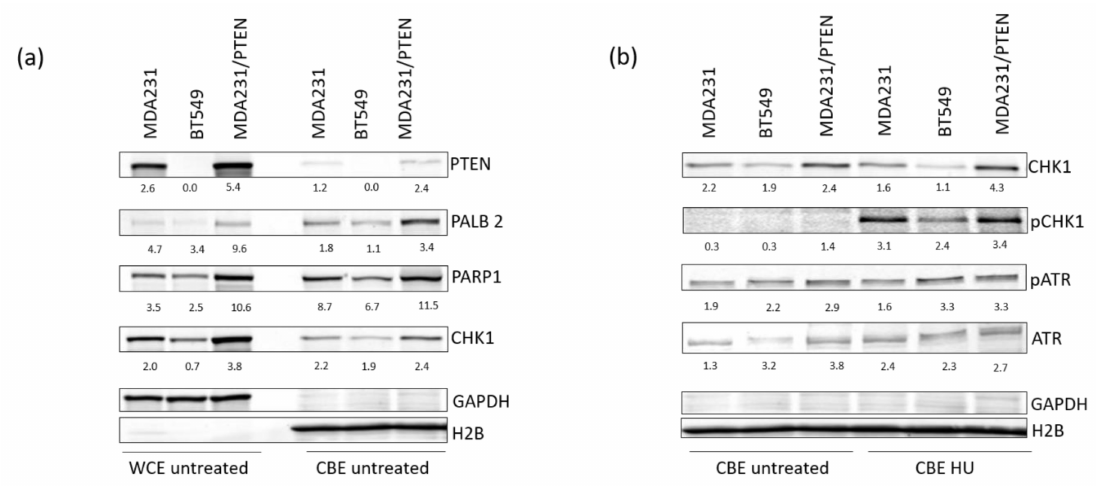
Figure 6. PTEN expression and recruitment of DNA repair proteins to the chromatin in TNBC. ( a ) Western blot analysis of PTEN, PALB2, PARP1 and CHK1 expression in whole cell extracts (WCE) and chromatin-bound extracts (CBE) of untreated TNBC cell lines. GAPDH and H2B served as a loading control for the WCE and CBE, respectively. ( b ) Western blot analysis of CHK1, pCHK1, ATR and pATR expression at the chromatin after treatment with 2 mM HU for 4 h in comparison to untreated controls. H2B served as a loading